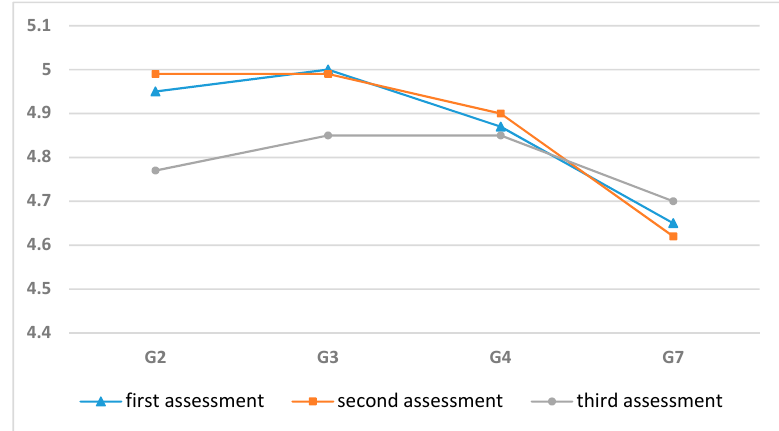
Figure 1. Horizontal comparison of the visual acuity of students in different grades.